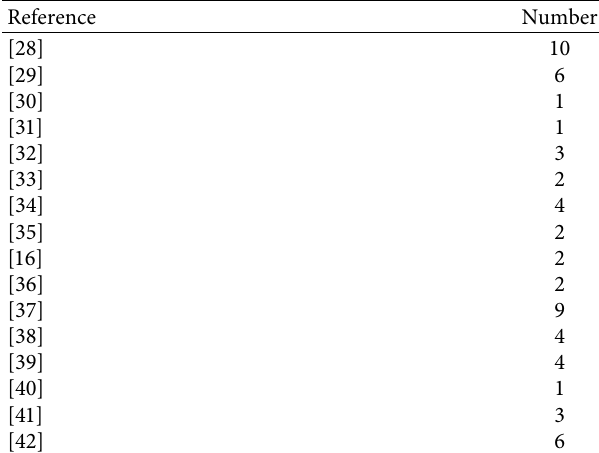
Table 1: Sources of the